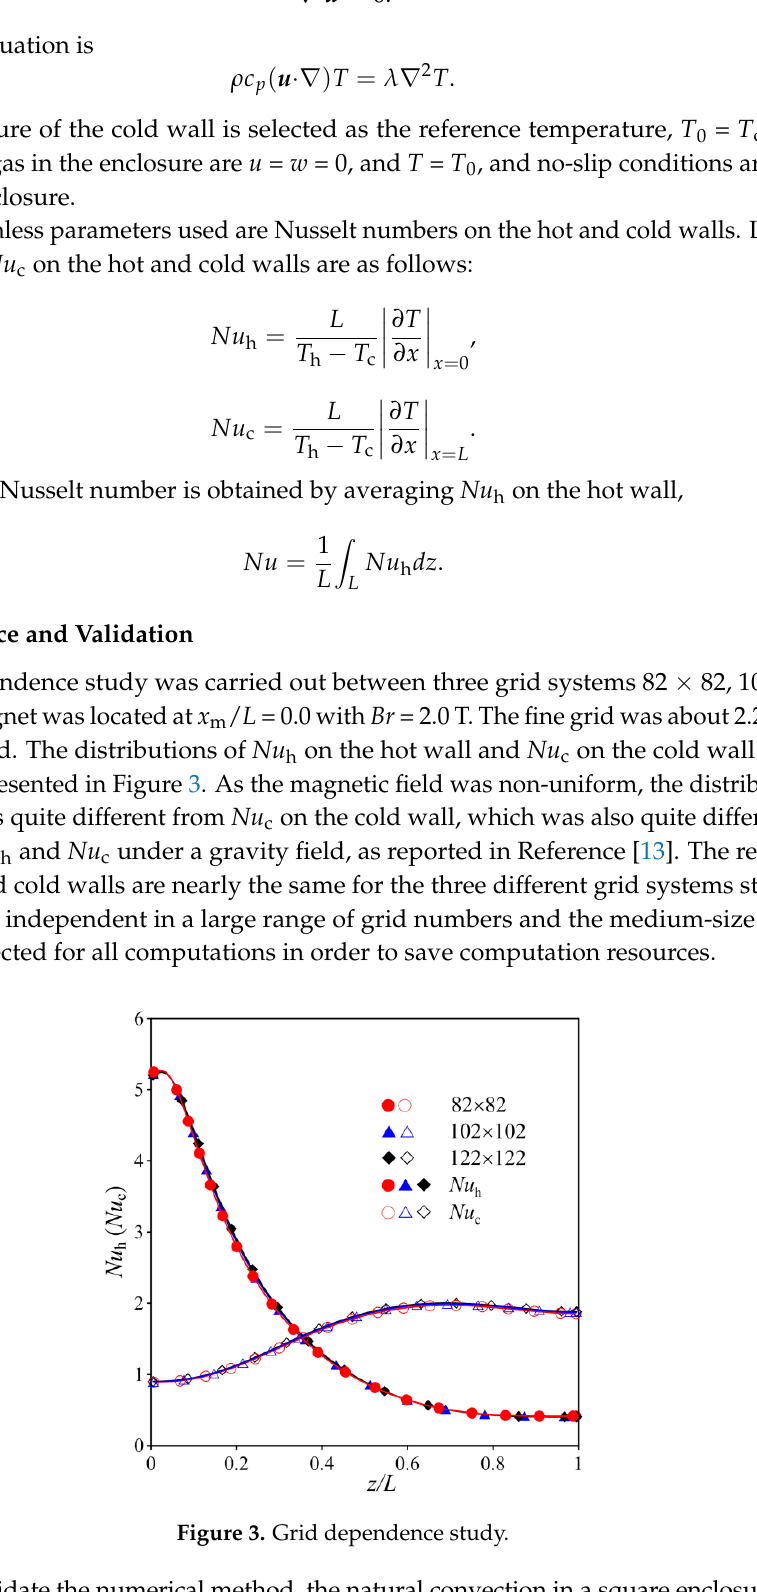
Table 2. Comparison of numerical results with previous work ( Ra = 10 5 ).